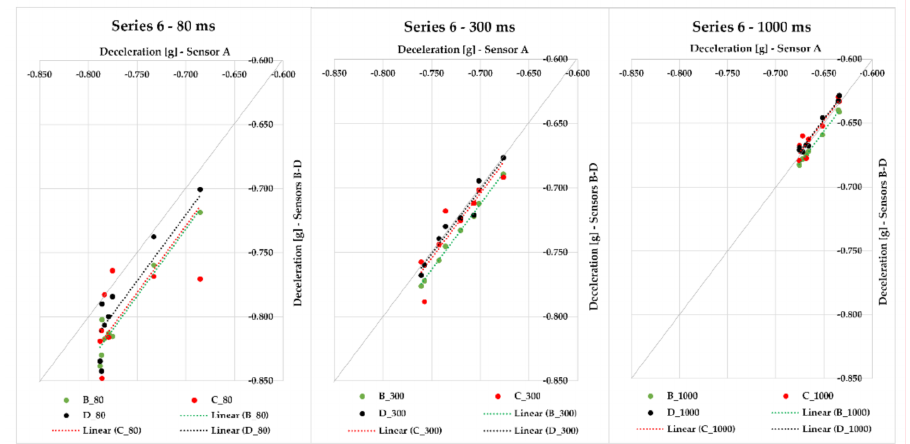
Figure 12. Series 6-Point dependency of individual MEMS sensors against sensor A.